Question: Summarize what this figure shows in one sentence.
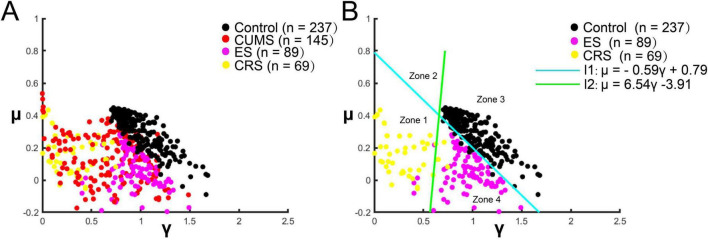
Answer: The distribution of each group of model mice across the two variable parameters of the LF. (A) The distribution of the two variable parameters of the LF (γ and μ). (B) A support vector machine was used to calculate two decision boundaries that distinguished the three data groups based on training data. The optimal linear separation between the control and CRS groups was defined by L1: μ = –0.59γ + 0.79, while L2: μ = 6.54γ –3.91 provided the optimal separation between the control and ES groups.